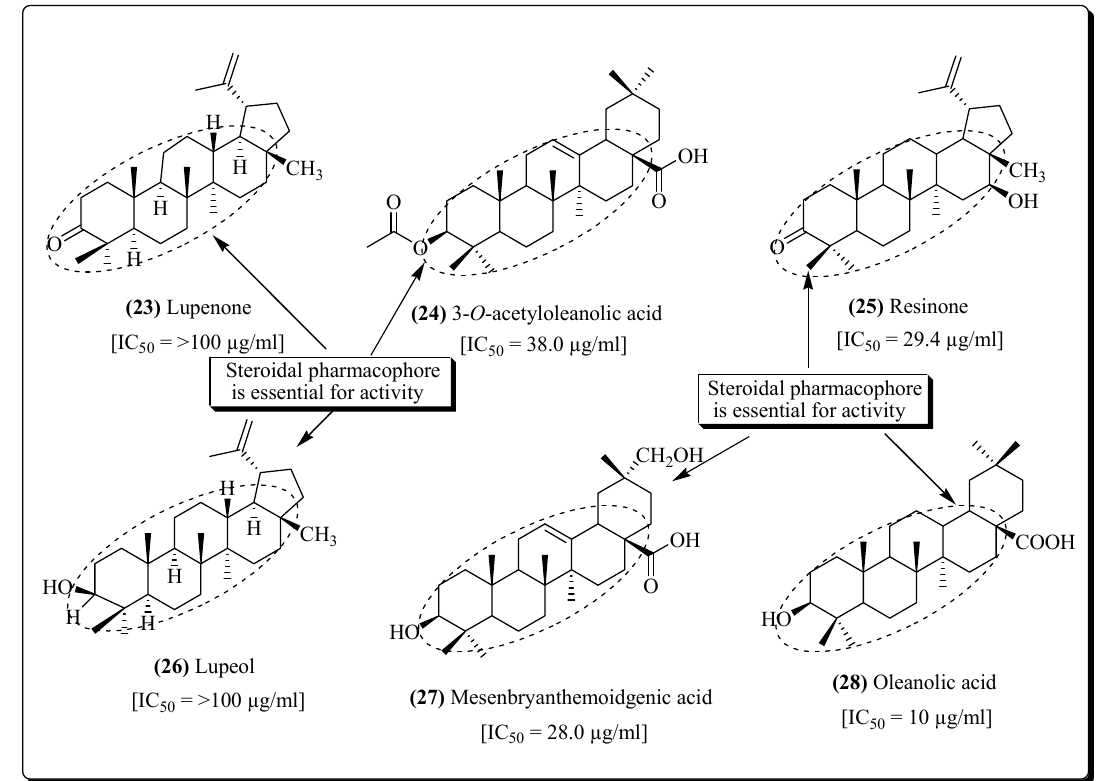
Figure 7. Compounds exhibiting protease inhibitory activity.